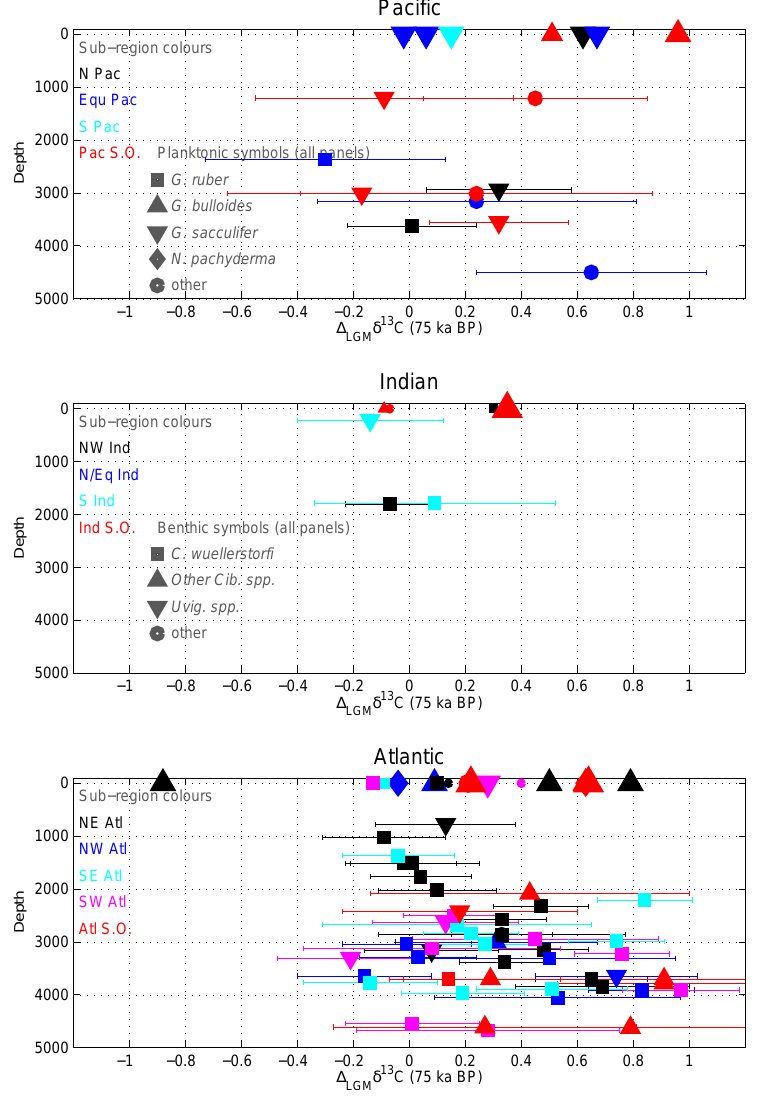
Fig. 13. 75ka 1 LGM δ 13 C time-slice, with 2 σ error bars on benthic